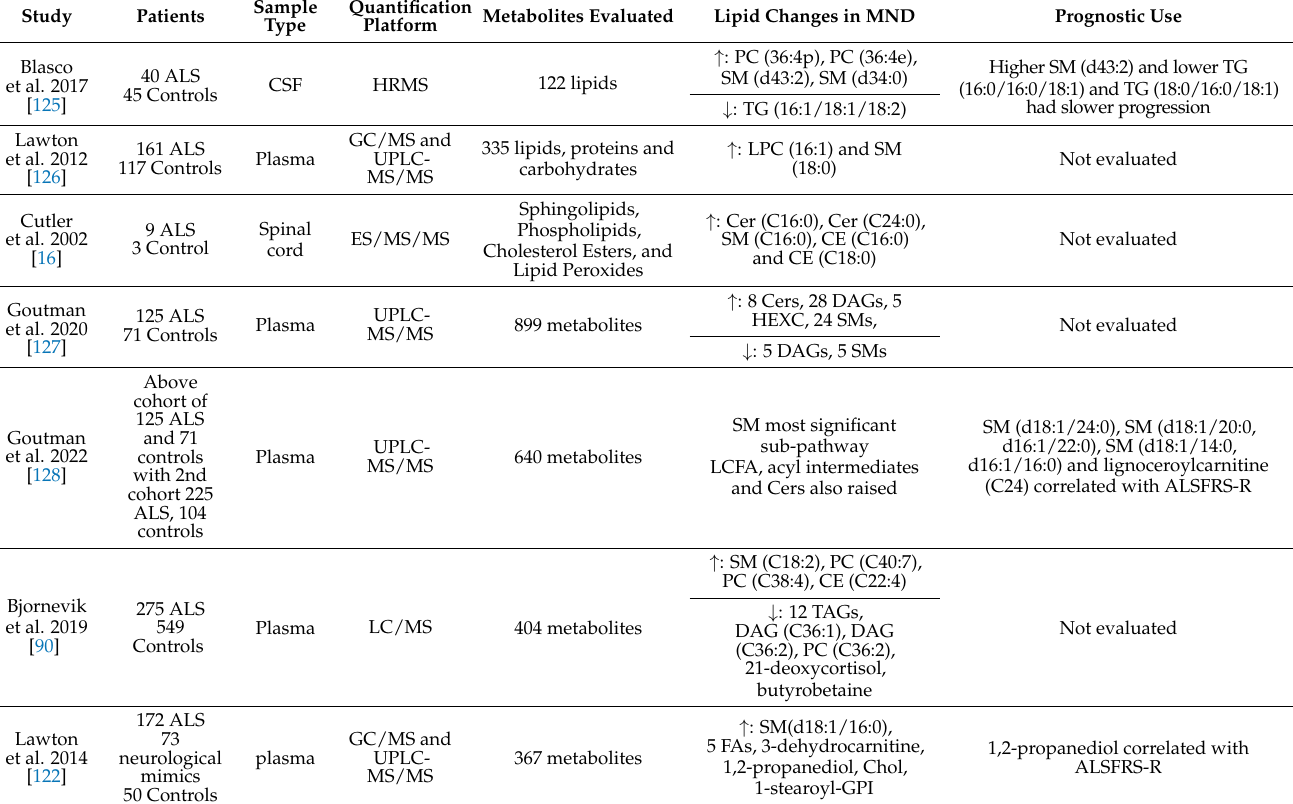
Table 2. Metabolomic studies in patients with ALS showing the changes in lipid